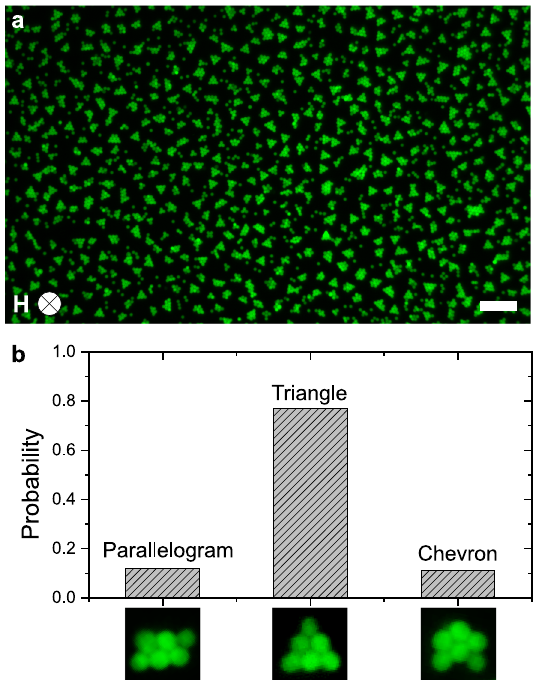
Fig. 7 Formation of isomeric clusters. a Dynamic clusters assembled with H = 365 A m − 1 . Scale bar: 20 μ m. b Measured frequency of occurrence of isomers for n = 6, with H = 325 A m − 1 . Fluorescence images show the measured shapes, i.e., from left to right, the parallelogram, triangle, and chevron